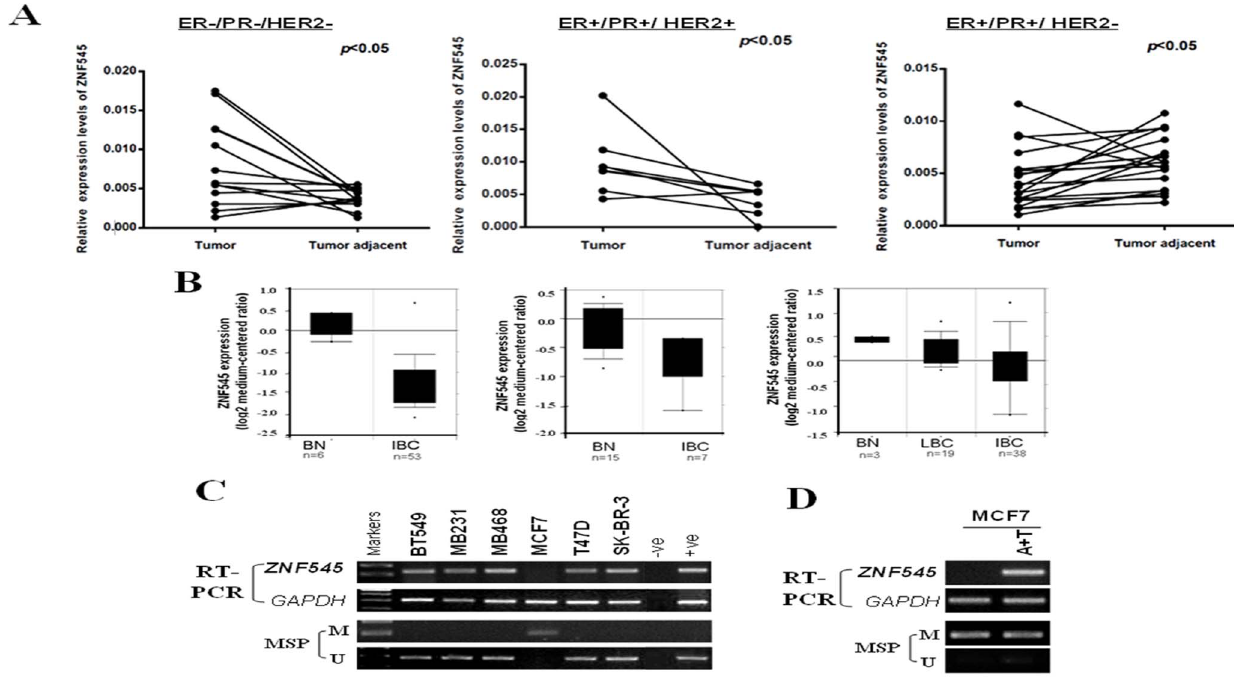
Figure 1. Downregulation of ZNF545 in breast cancer. (A) ZNF545 expression in primary breast tumor tissues and paired surgical margin tissues were evaluated using quantitative RT-PCR analysis. (B) Reduced expression of ZNF545 in breast cancer. Data extracted from cancer microdatabase Oncomine: https://www.oncomine.org/. BN: Normal Breast tissues; IBC: Invasive Breast Carcinoma; LBC: lobular breast carcinoma. (C) ZNF545 expression by semi-quantitative RT-PCR and methylation status of the ZNF545 promoter by MSP in breast cancer cell lines. GAPDH was used as a control. (D) Pharmacological demethylation restores expression of ZNF545 in MCF7 cell treated with Aza combined with TSA (A + T), accompanied by demethylation of the promoter. M, methylated; U, unmethylated.